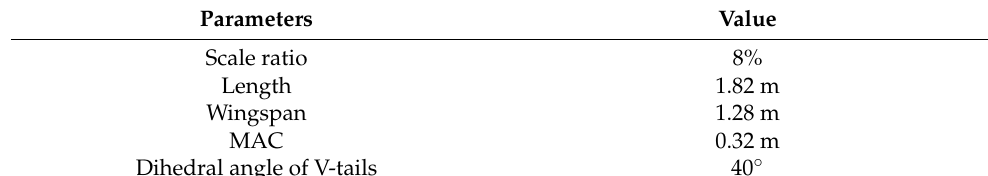
Table 1. Model geometric parameters.